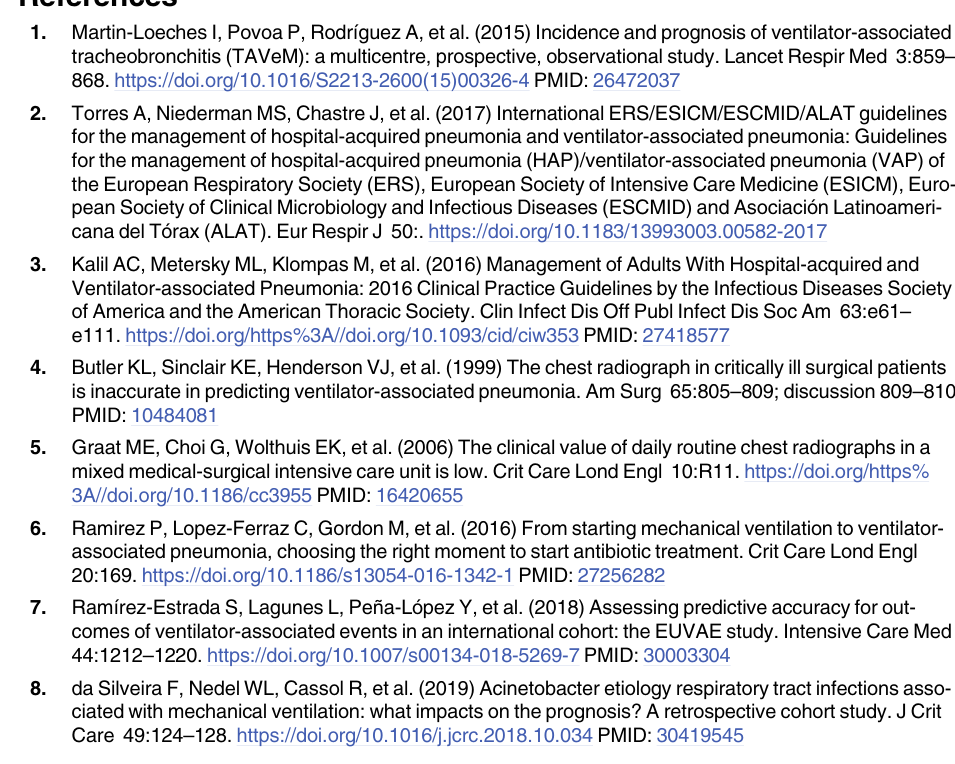
S2 Fig. ROC curves of Δ (A), total SOFA (B), and respiratory SOFA (C) for the predic- SOFA tion of mortality on ICU discharge in patients with VA-LRTI. SOFA sequential organ failure